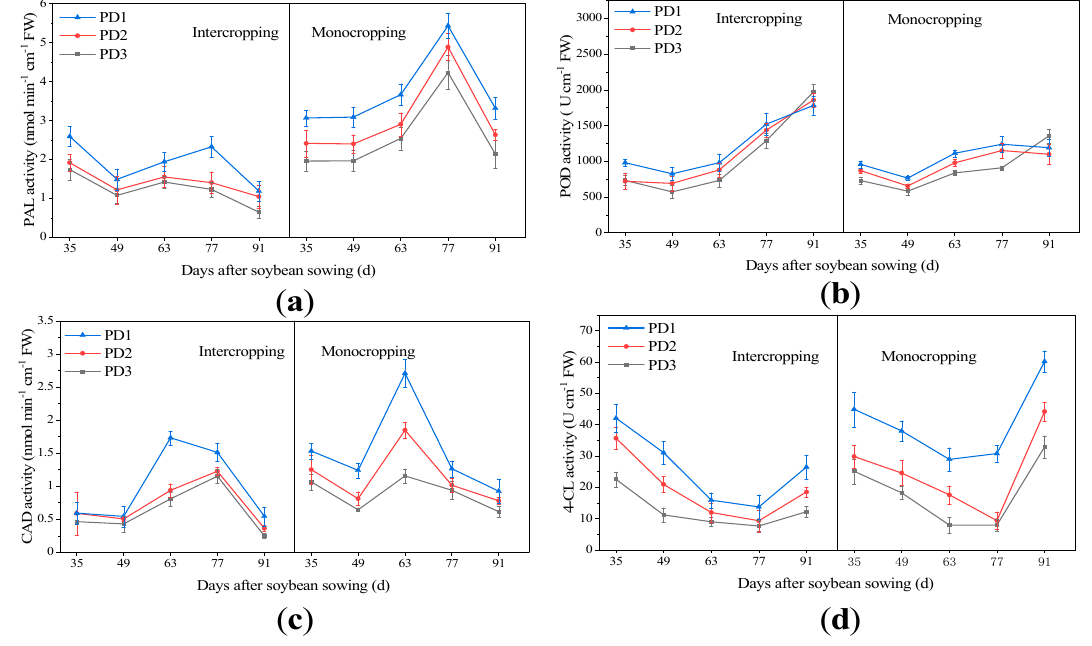
Figure 7. Effects of multiple planting densities (PD1 = 17, PD2 = 20, and PD3 = 25 plants m − 2 ) on PAL ( a ), POD ( b ), CAD ( c ), and 4CL ( d ) under both strip intercropping system and monocropping. All the values are means (±SE) standard error of three replications.